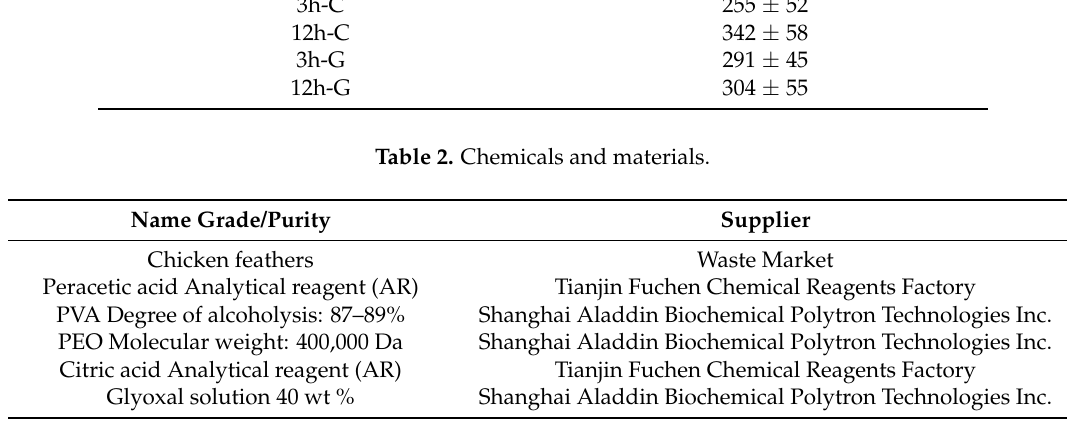
Table 1. The average diameter of the FK/PVA/PEO nanofiber membranes with different vapor- assisted crosslinking modifications.